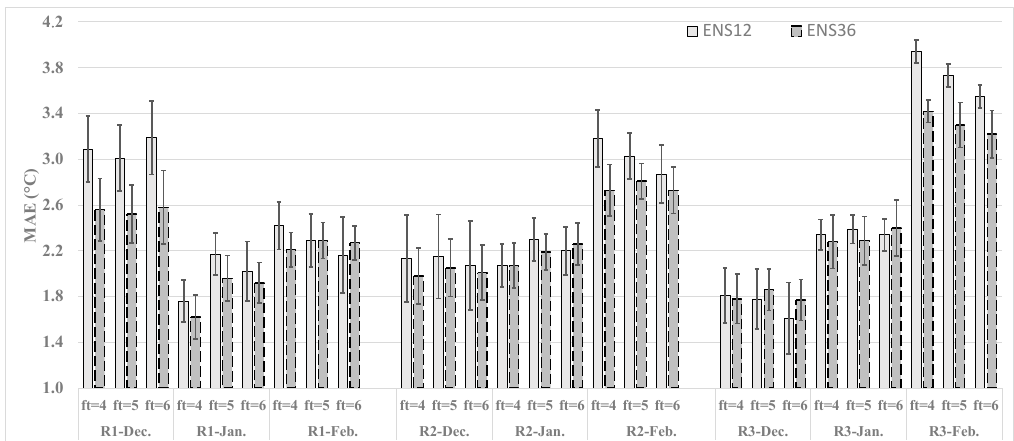
Figure 6. Mean absolute error with 95% confidence intervals of ENS12 (gray charts) and ENS36 (gray dashed charts) for forecast times (ft) of four, five, and six months for different subclimate regions (R1, R2, R3) and different target months (December, January, February). The unit is o C.